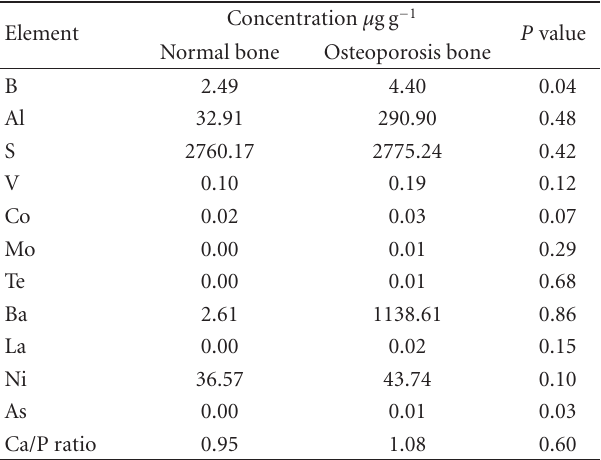
Table 1: Average of atomic mineral concentrations which is higher in osteoporosis